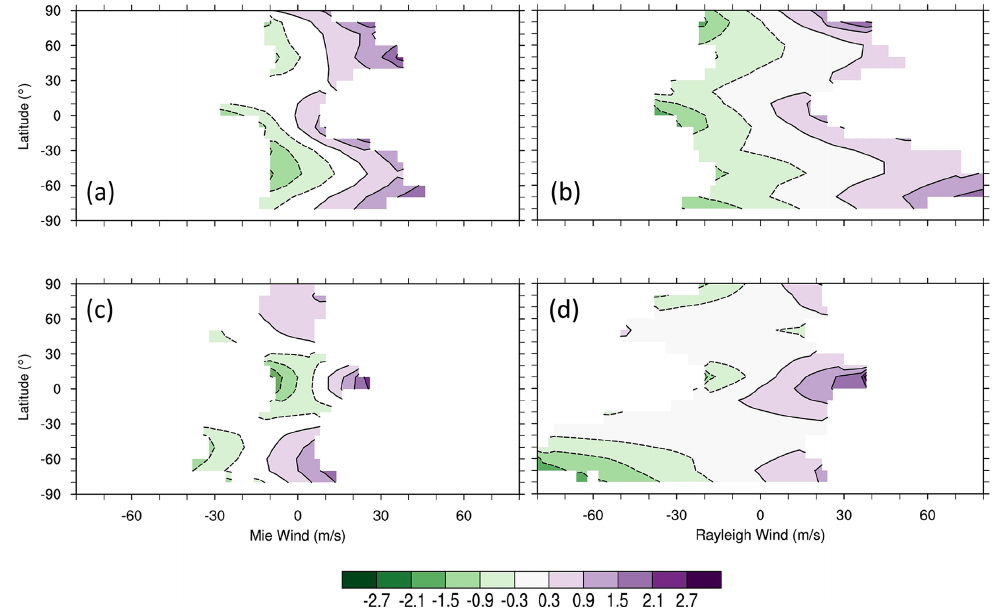
Figure 11. Latitudinal distributions of average TLS estimated biases (color scale; ms − 1 ) for Mie (a, c) and Rayleigh (b, d) winds as a function of Aeolus wind in ascending (a, b) and descending (c, d) orbits, obtained from the TLS fits displayed in Fig. 10.